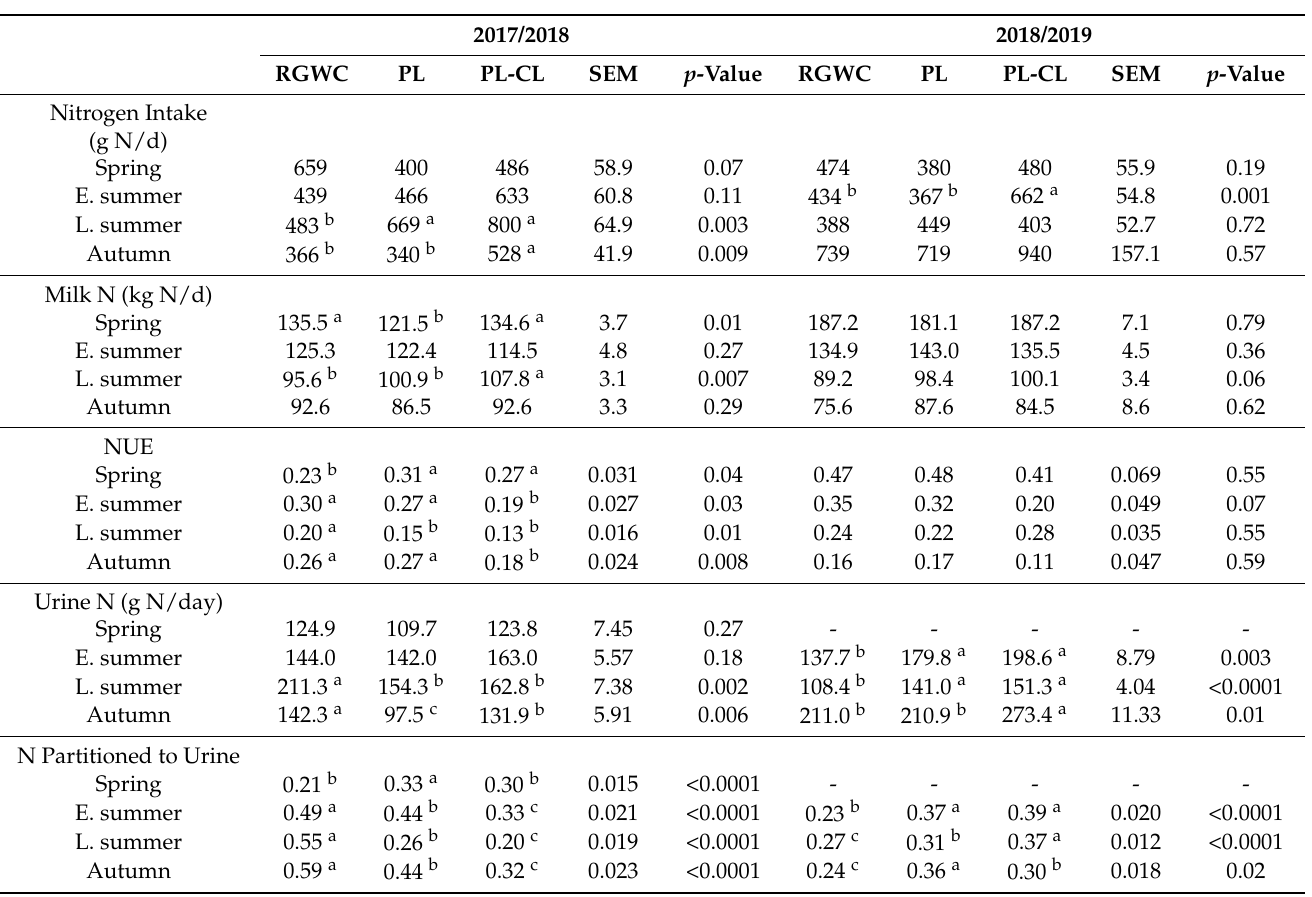
Table 3. Nitrogen (N) intake, milk N yield, N use efficiency (NUE), and urine N excretion and N partitioned to urine by lactating cows grazing plantain (PL), plantain–clover (PL-CL), and ryegrass– white clover (RGWC) pastures in spring, summer (early and late), and autumn during the 2017/2018 and 2018/2019 lactation